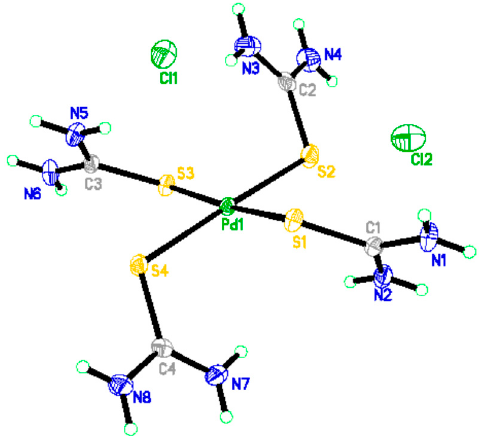
Figure 12. Plot of final pH versus initial pH for determination of pH pzc.